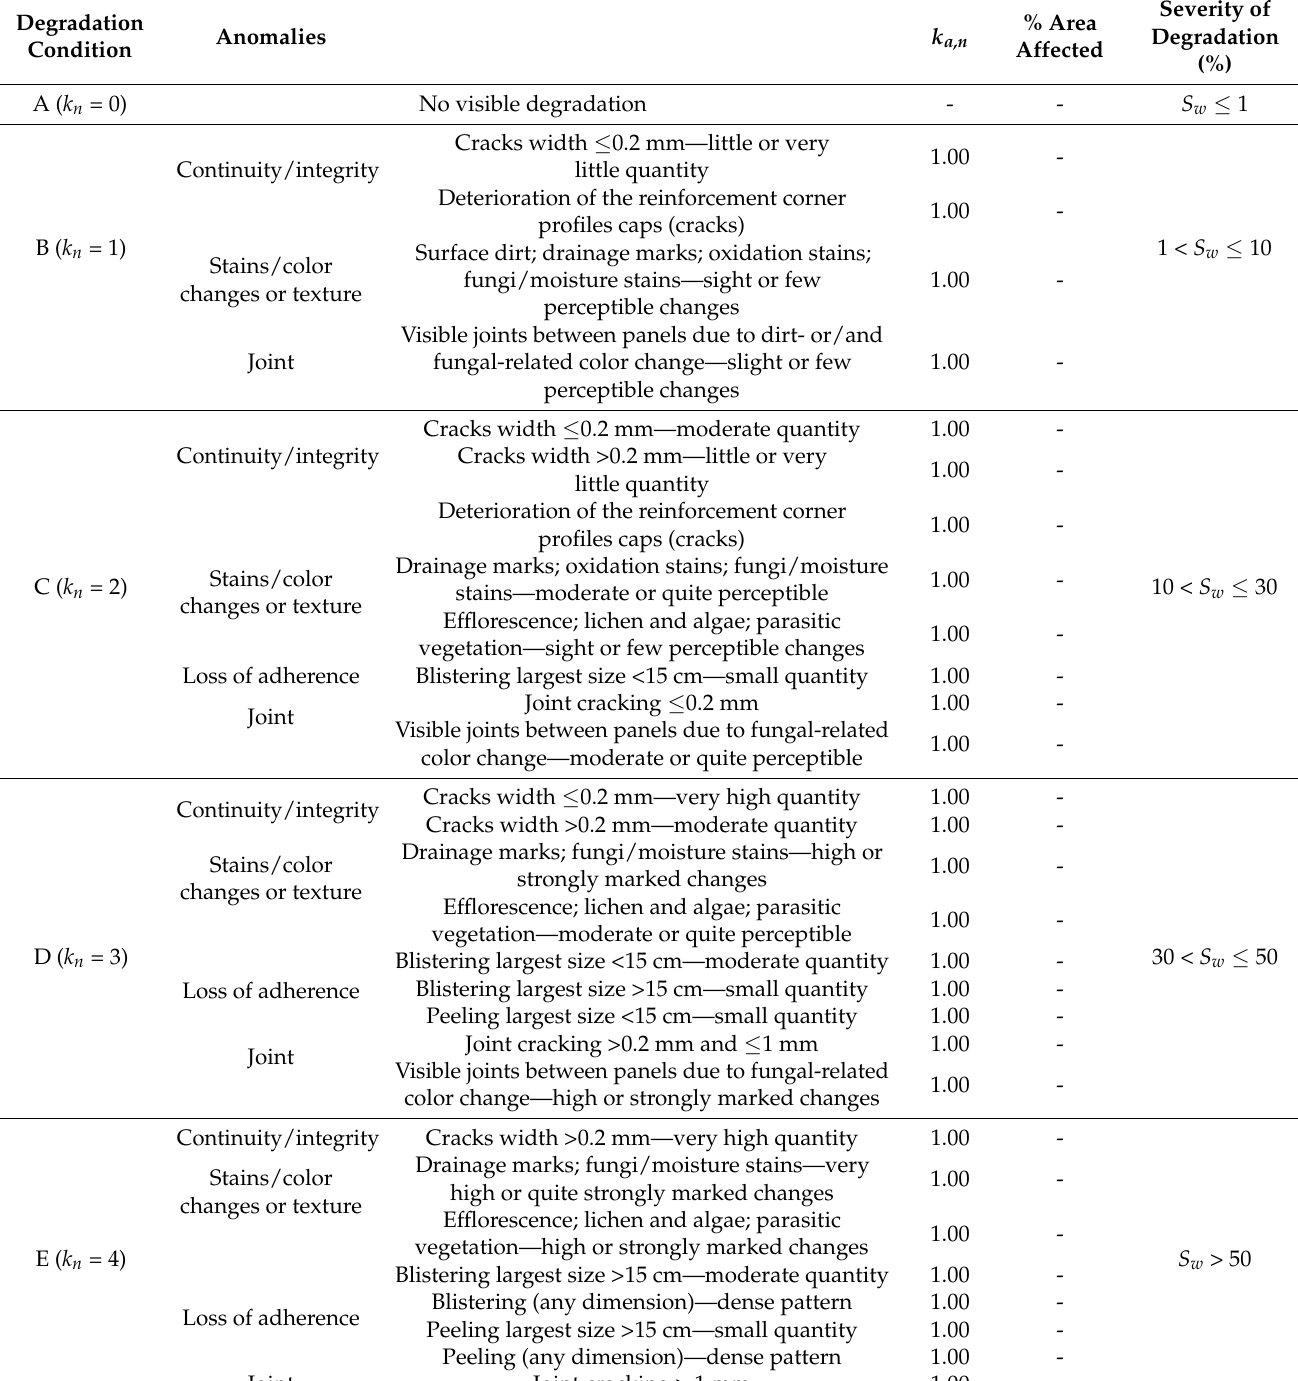
Table A3. Classification system for external thermal insulation composite systems (ETICS) [39].